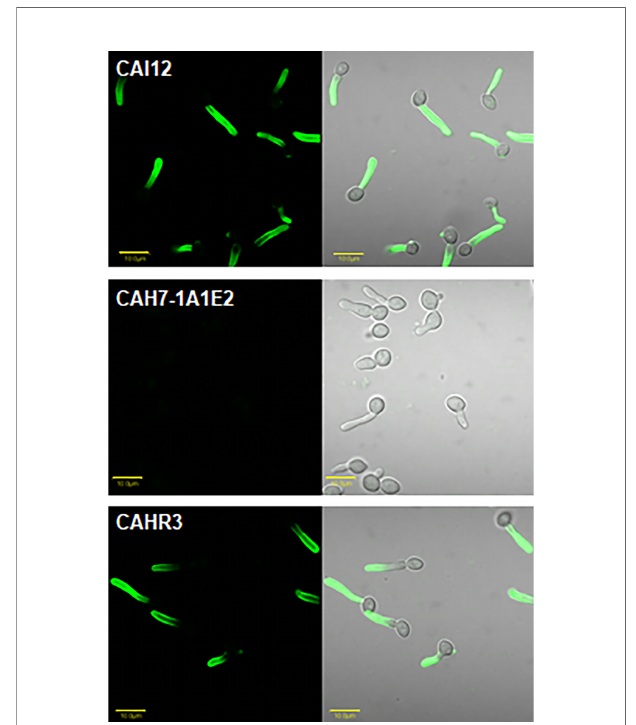
FIGURE 1 | Immunolabeling of C. albicans cells to demonstrate speci fi city of anti-Hwp1 MAb 2-E8. Immunolabeling using the anti-Hwp1 MAb 2-E8 and a FITC-labeled goat anti-mouse secondary antibody only produced a visible signal in C. albicans strains that had at least one HWP1 copy. Immunolabeling was visible only on the germ tube, not the yeast cell, consistent with previously reported HWP1 expression patterns (Staab et al., 1996). The scale bar in each image denotes 10 m